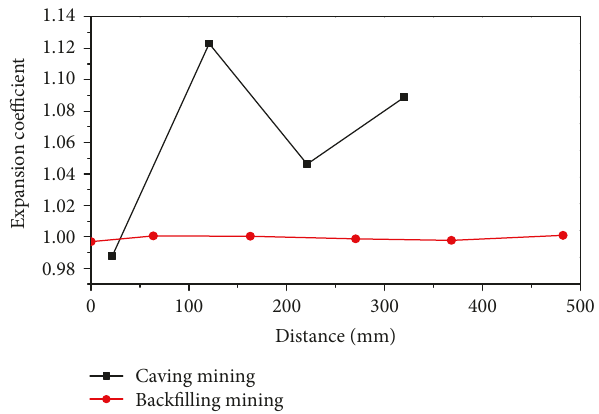
Figure 10: Comparison between interior rock expansion of overlying strata in the back fi lling mining model and the caving mining model.